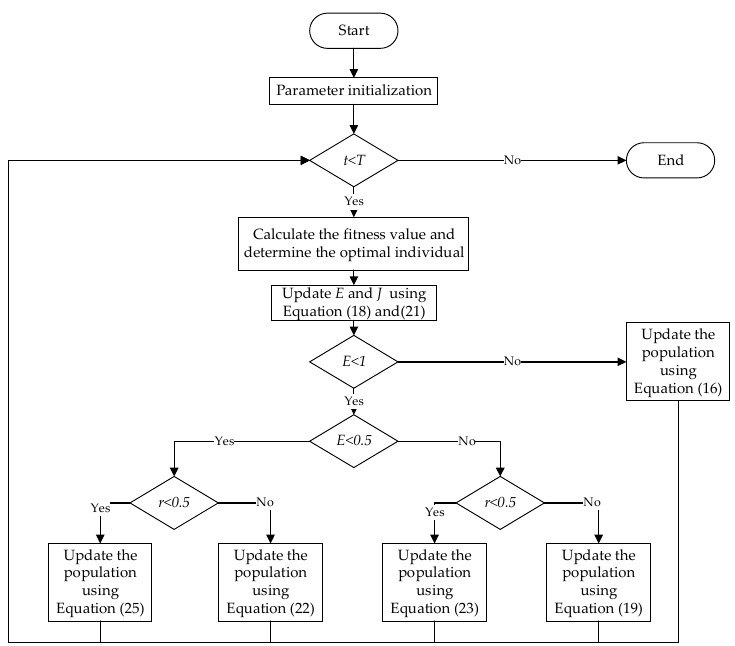
Figure 3. The flow chart of the HHO